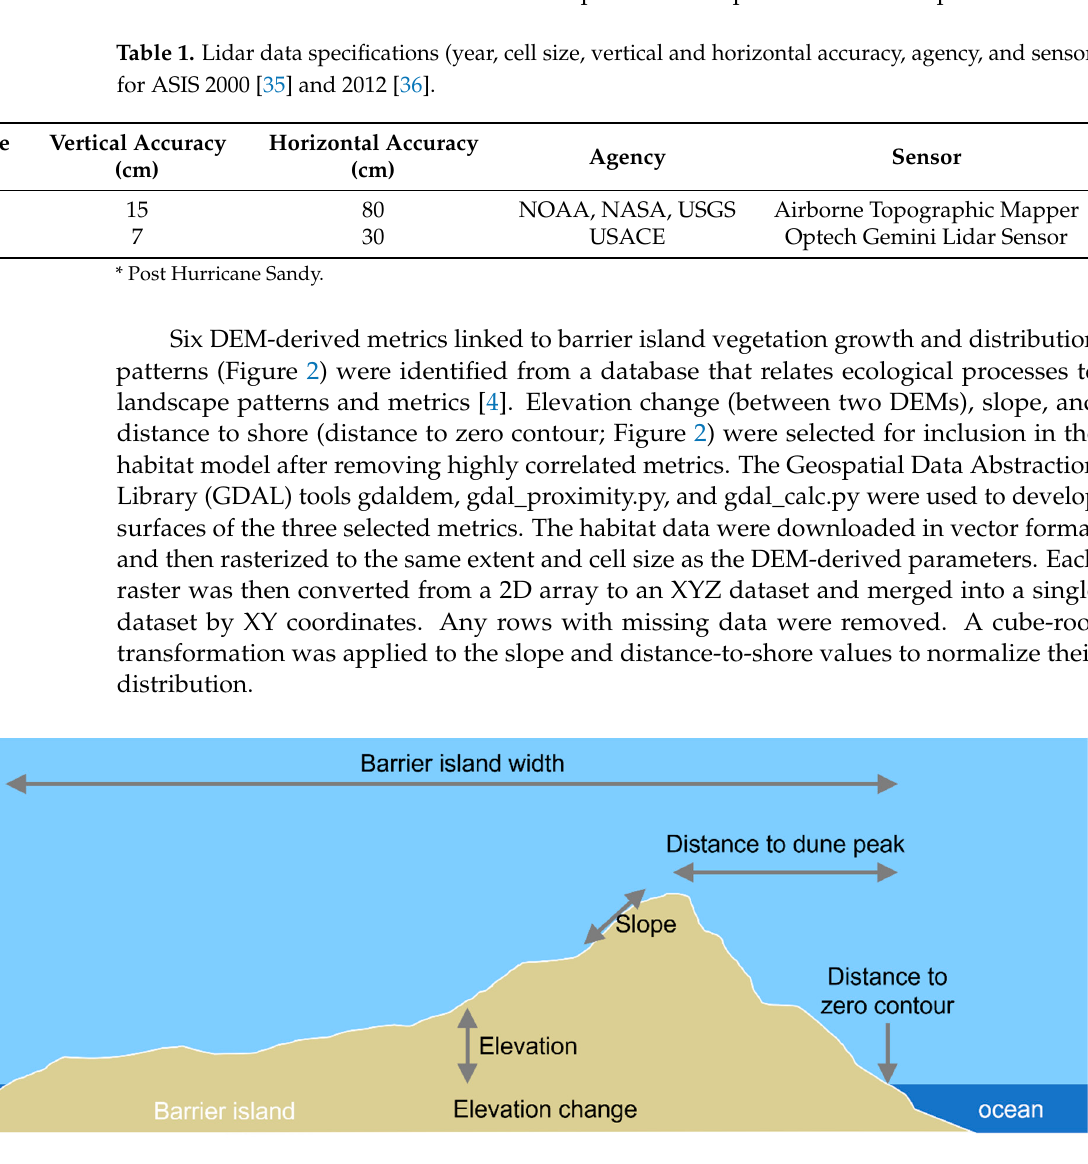
Figure 2. Six parameters that are derived from a DEM that influence vegetation growth and distribution on a barrier island.